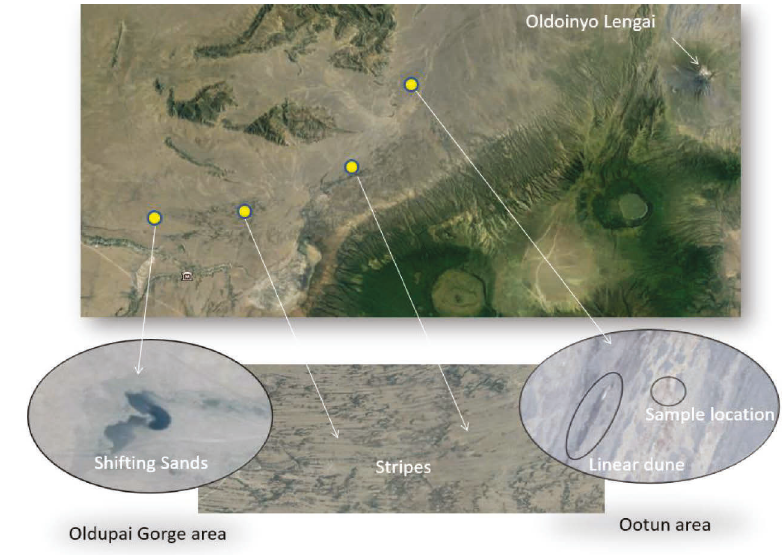
Figure 3: The image from the landscape across the study area shows around 84km wide, with the shifting sands (SSs) in the west, Ootun sands (OTSs) at the center, and Oldoinyo Lengai in the east (source: Google Earth